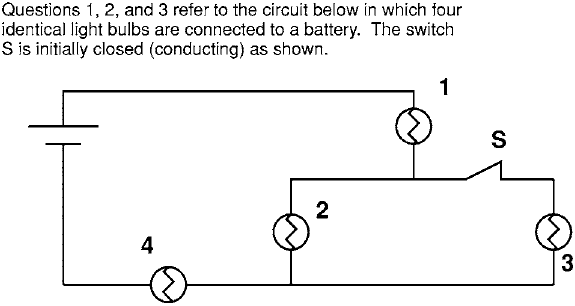
FIG. 2. Schematic diagram on final examination relating to questions